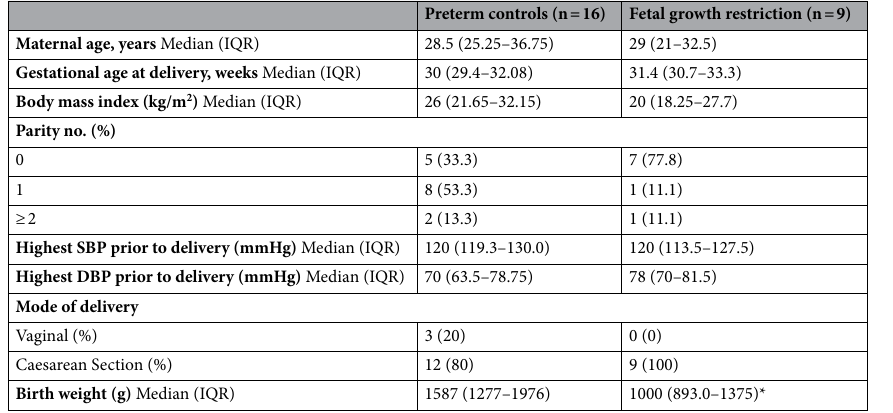
Caesarean Section (%) 12 (80) 9